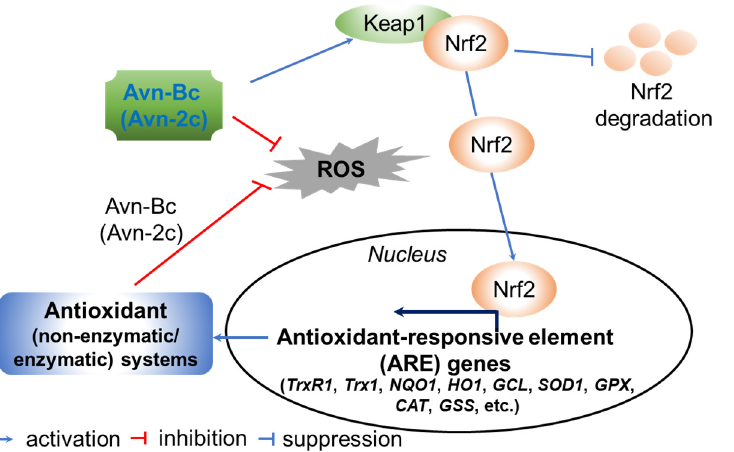
Figure 10. A proposed action mode of avenanthramide (Avn)-derived antioxidant activity. Avn-Bc unties the complex of nuclear factor erythroid 2-related factor 2 (Nrf2) and Kelch-like ECH-associated protein 1 (Keap1). Detached Ntf2 moves to the nucleus, binds to the antioxidant-responsive element (ARE) domain, and activates a wide range of cytoprotective and antioxidative genes, including thioredoxin reductase (TrxR1), thioredoxin 1 (Trx1), NAD(P)H:quinone oxidoreductase (NQO1), heme oxygenase 1 (HO-1), glutamate-cysteine ligase (GCL), superoxide dismutase 1 (SOD1), glutathione peroxidase (GPX), catalase (CAT) and glutathione synthetase (GSS), at the transcriptional and translational levels under oxidative stress conditions. The activated antioxidant systems improve redox homeostasis by neutralizing reactive oxygen species (ROS). Thus, Avn-Bc enhances cell homeostasis in response to oxidative stress [99,112].